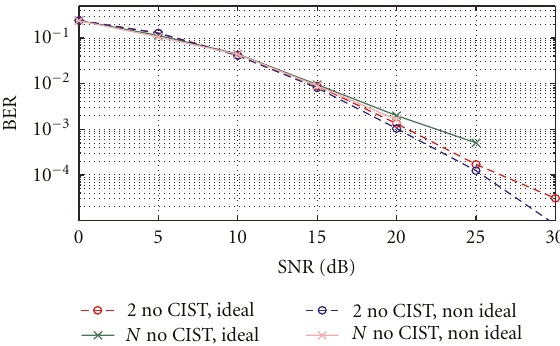
Figure 12: Average sum rate, as a function of the SNR, for N = 10 base stations with 5 collaborating CFR paris and N = 2 isolated BSs. α = 0 . 1 and the modulation scheme is